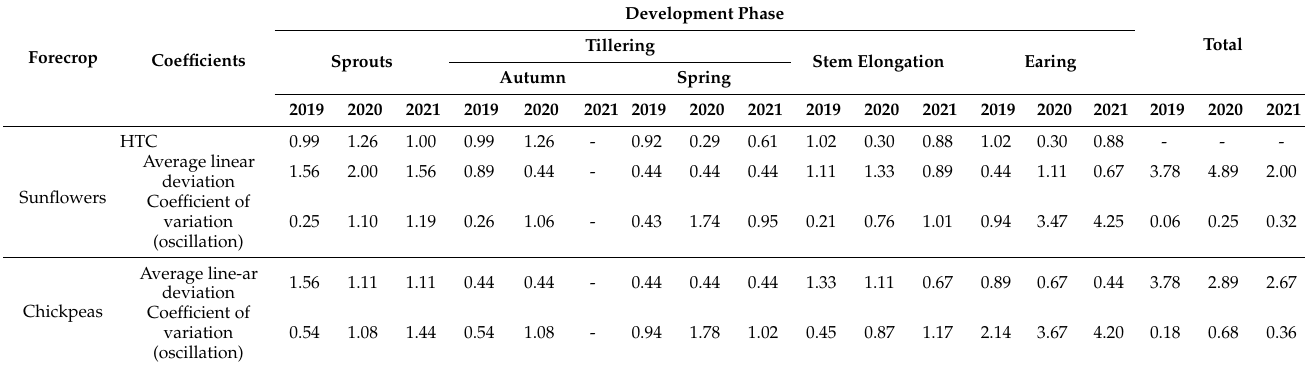
Table 3. Duration of interphase periods,